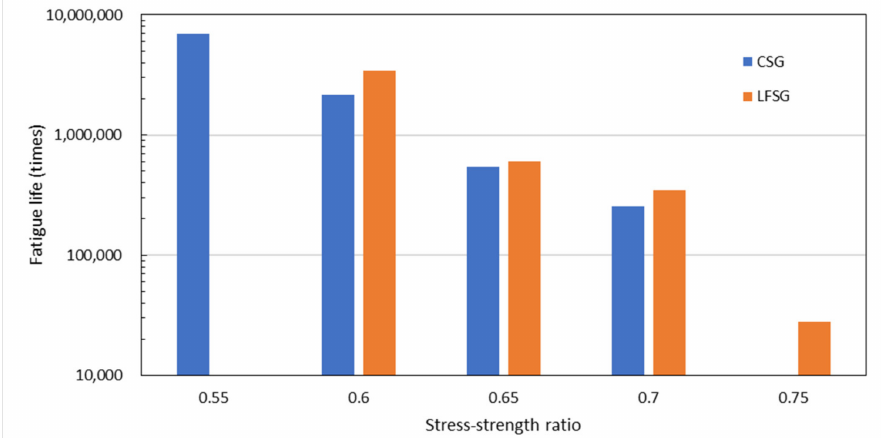
Figure 9. Average fatigue life of CSG and LFSG in different stress–strength